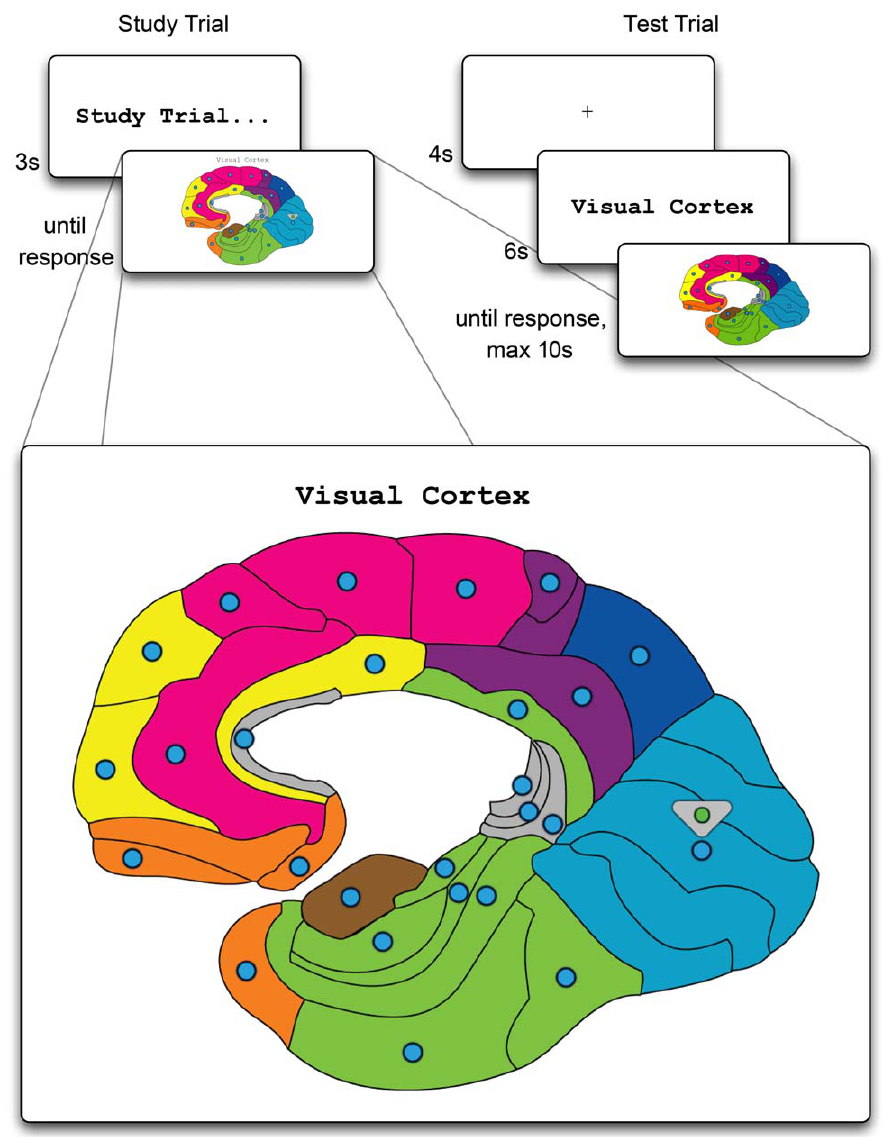
Figure 1. Example of a study trial (left side) in which a new paired-associate is presented, and a test trial (right side) during which the pupil dilation is measured. Note that after the test trial a feedback screen (not shown) was provided. The zoomed-in bottom part of the figure shows the learning screen with the name of the area being presented on the top of the screen, and a small triangle indicating the corresponding